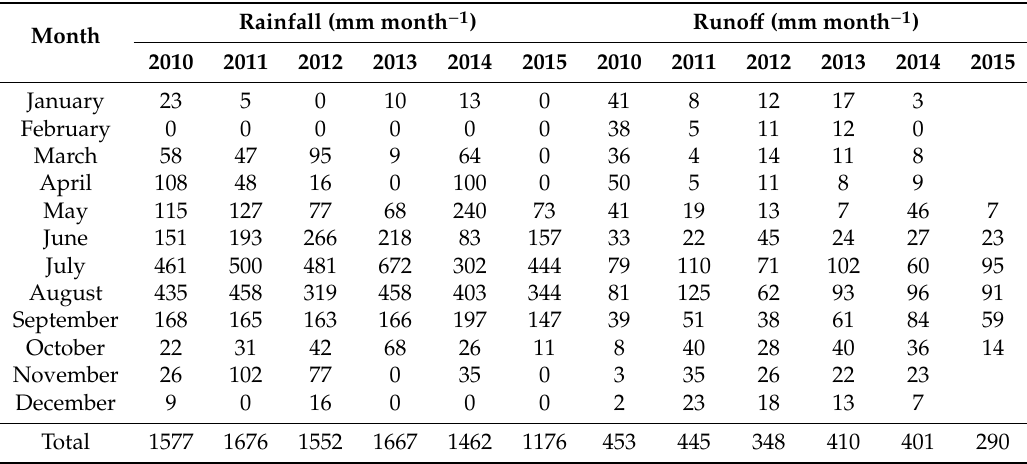
Figure 2. Rainfall intensity and the infiltration rate of the Tikur-Wuha watershed. Table 1. Monthly rainfall amount and observed flow (mm) of the Tikur-Wuha watershed from 2010 to 2015.